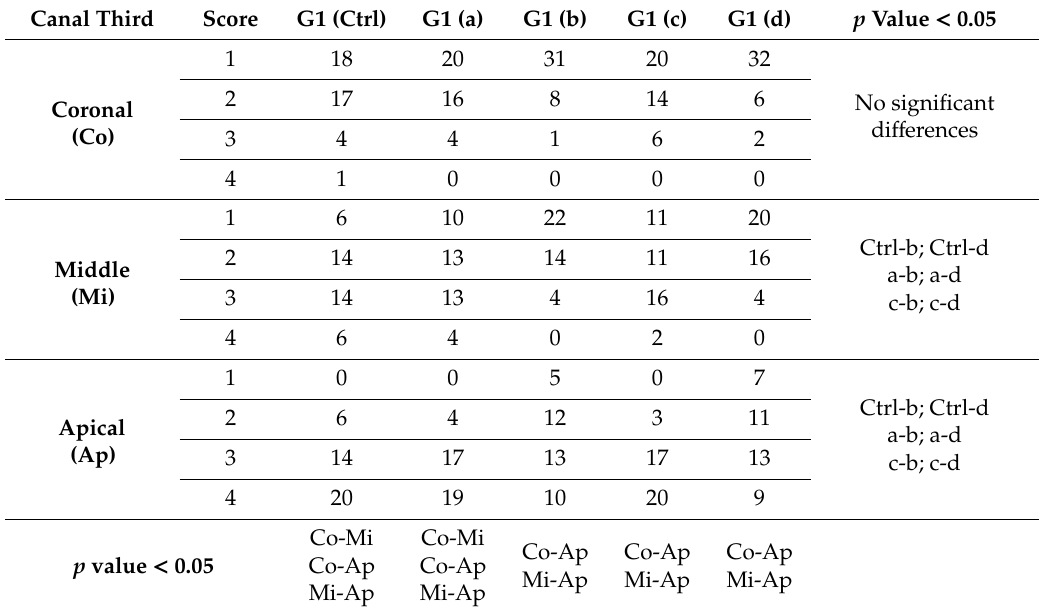
Table 1. Number of samples registered for each score of smear layer removal in the di ff erent root canal thirds for the di ff erent irrigation techniques of G1 (without pre-endodontic restoration). Abbreviations in the last column and last row indicate significant di ff erences between the di ff erent subgroups and / or thirds ( p < 0.05); Co: Coronal, Mi: Middle, Ap: Apical; Subgroups: ctrl, a-d.